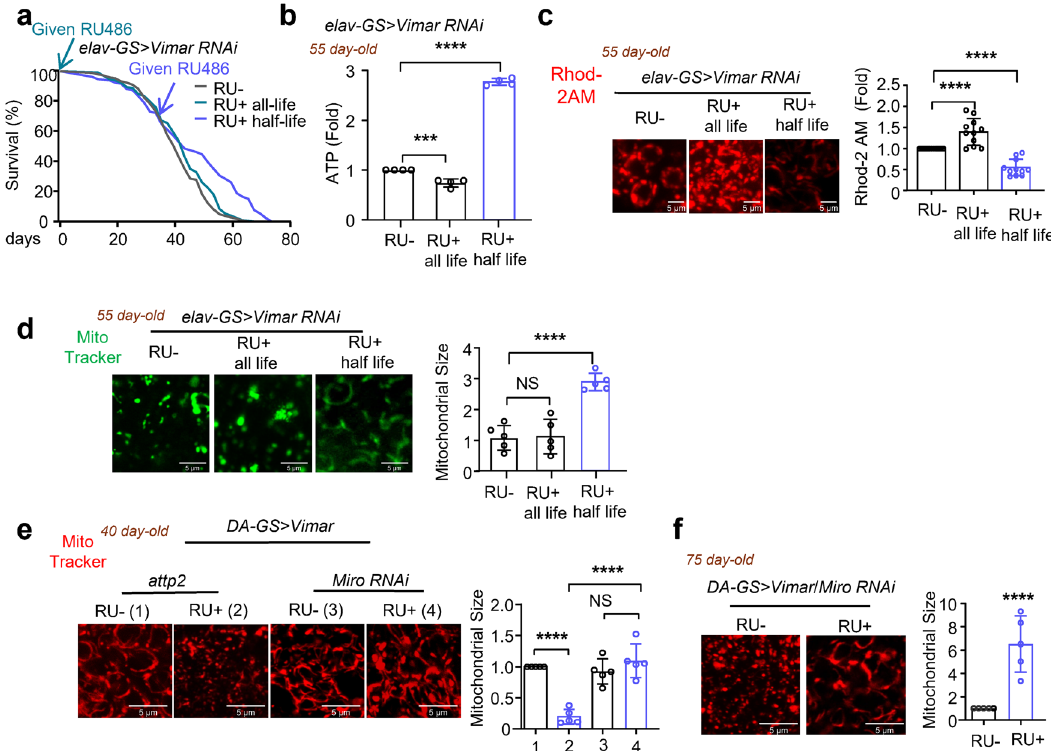
Fig. 3 Effect of Vimar RNAi on aging. a Survival curve of elav-GS-Gal4 > Vimar RNAi fl ies. The gray line is the control without induction of Vimar RNAi (RU − ). The blue line is given RU486 from 1 day-old and kept on whole life (RU + all-life). The red line is given RU486 from 30 day-old and kept on the rest of life (RU + half-life). Each vial contained 10 female and 10 male fl ies. Total fl ies tested N = 179 (RU − ), N = 134 (RU + all life), N = 134 (RU + late). Median lifespan: RU − = 48 days, RU + all-life = 49 days, RU + half-life = 54 days. Long-rank test, P = 0.689 (RU − vs RU + all-life); P = 0.00276 (RU − vs RU + half-life). b Brain ATP level. The same fl y group as a is tested, with 55 day-old of fl ies. Each experiment collected 40 fl y heads. The average ATP level of control (RU − ) was set as 1, with the ATP level was normalized to protein concentration. The relative ratios of the other fl ies are shown. Trial N = 4. One- way ANOVA with Tukey ’ s post hoc test. *** P = 0.0005, **** P < 0.0001. c Representative live image of mitochondrial calcium level measured by Rhod2- AM. The same fl y group as a is tested, with 55 day-old of fl ies. Scale bar, 5 μ m. The averaged intensity of control (RU-) was set as 1, and the relative ratios of RU + all-life and RU + half-life to the control (RU − ) are shown. Three area (400 μ m 2 ) were averaged for each brain sample. Trial N = 11. One-way ANOVA with Tukey ’ s post hoc test. **** P < 0.0001, **** P < 0.0001. d Representative live image of mitochondrial morphology. The same fl y group as a is tested, with 55 day-old of fl ies. Mitochondria are labeled by Mito Tracker green, scale bar, 5 μ m. The bar graph showed the quanti fi cation, fl ies tested N = 5. One-way ANOVA with Tukey ’ s post hoc test. “ NS ” for not signi fi cant, P = 0.765, **** P < 0.0001. e Representative live image of mitochondrial morphology. Mitochondria are labeled by Mito Tracker red, scale bar, 5 μ m. The “ attp2 ” genotype is DA-GS-Gal4 ; UAS-Vimar/attp2 ; and “ Miro RNAi ” is DA- GS-Gal4; UAS-Vimar/Miro RNAi . 40 day-old of fl ies were tested. The average mitochondrial size of control (RU-) was set as 1, and the relative ratios of other fl ies are shown. Tested fl y N = 5. One-way ANOVA with Tukey ’ s post hoc test. **** P < 0.0001, **** P < 0.0001, “ NS ” for not signi fi cant, P = 0.188. f Representative live image of mitochondrial morphology. The genotype is DA-GS-Gal4 > Vimar/MiroRNAi , fed with RU486 or not. The control DA-GS- Gal4 > Vimar/attp2 (RU − ) is the genetic matched background of above fl y line. 40 day-old were tested. Mitochondria is labeled by Mito Tracker red. Scale bar, 5 μ m. The average mitochondrial size of DA-GS-Gal4 > Vimar/attp2 (RU − ) is set as 1, and the relative ratios of other fl y lines are shown. Tested fl y N